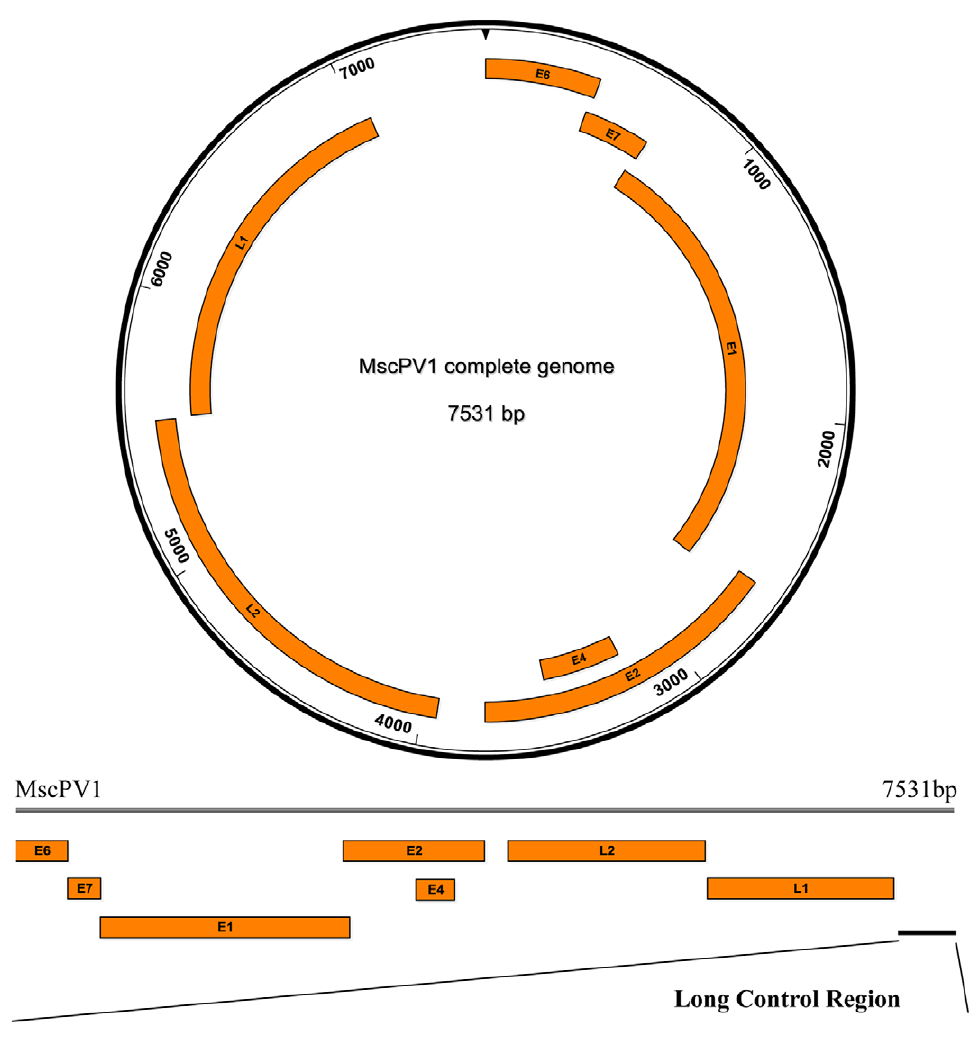
Figure 2. Circular and linear genome maps of Miniopterusschreibersii papillomavirus type 1 (MscPV1). Characteristic features of the long control region of MscPV1, showing genomic locations of E2 binding sites (bold), polyadenylation sites (underlined), and TATA box